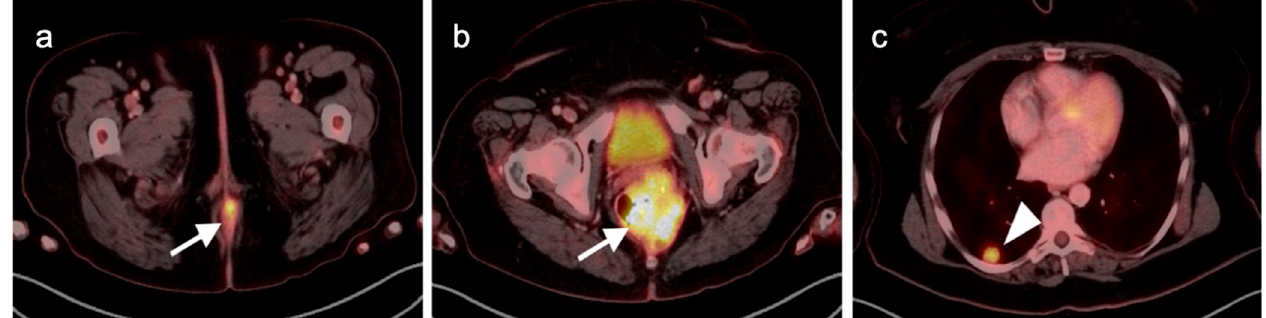
Figure 40. Large anorectal cancer. ( a ) Squamous cell carcinoma of the anus (white arrow), hyper- metabolic on an axial fused FDG PET-CT of the low pelvis; ( b ) On an axial fused FDG PET-CT image of the pelvis, tumor extends into the rectum as a bulky hypermabolic mass (white arrow); ( c ) In keeping with behavior of rectal tumors, anal cancer that extends significantly into the rectum is frequently associated with lung metastases, as in this case on an axial fused PET-CT of the low chest (white arrowhead).